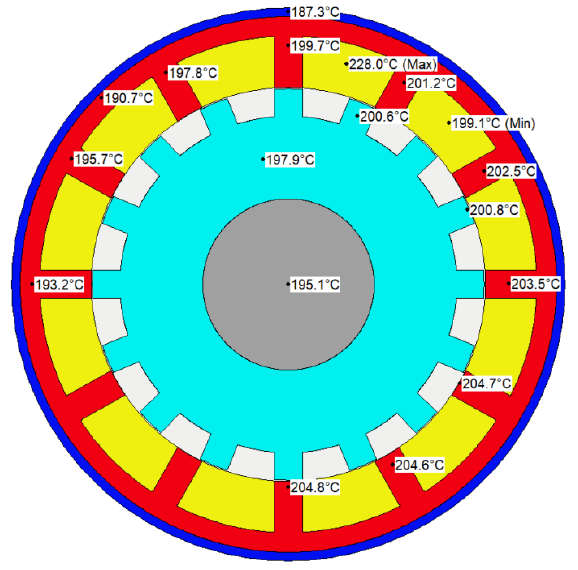
Figure 12. The steady-state temperature of the motor computed in